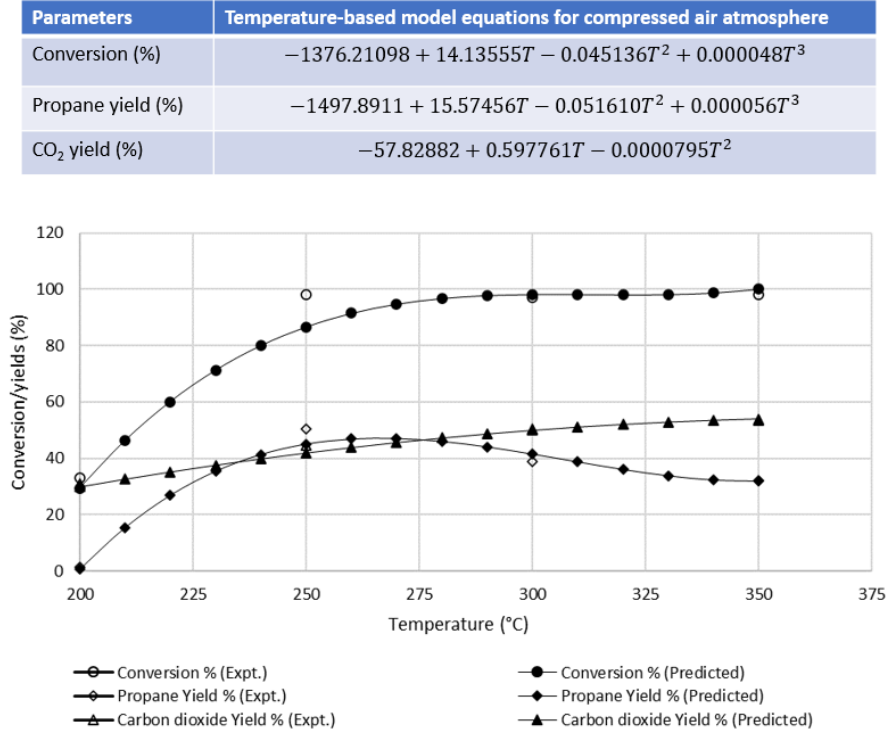
Figure 4. Comparisons between experimental and temperature-based model equations on butyric acid conversion and yields of propane and CO 2 under initial compressed air pressure of 5 bar.